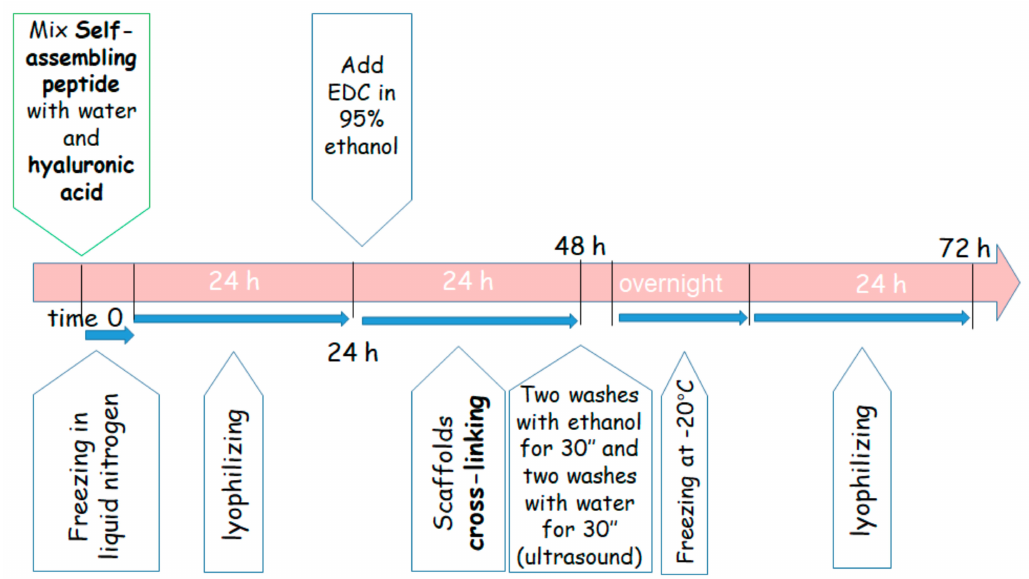
Figure 1. Steps of the procedure for the 3D sca ff old